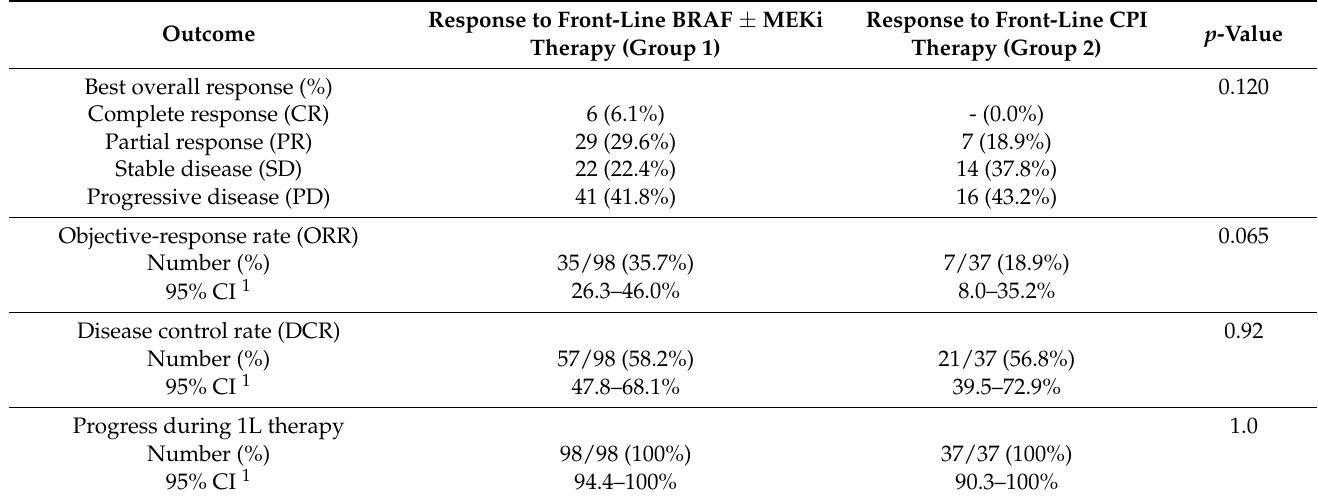
Table 2. Response to front-line treatment in patients with consecutive treatment with CPI and TT stratified by the sequence regimen